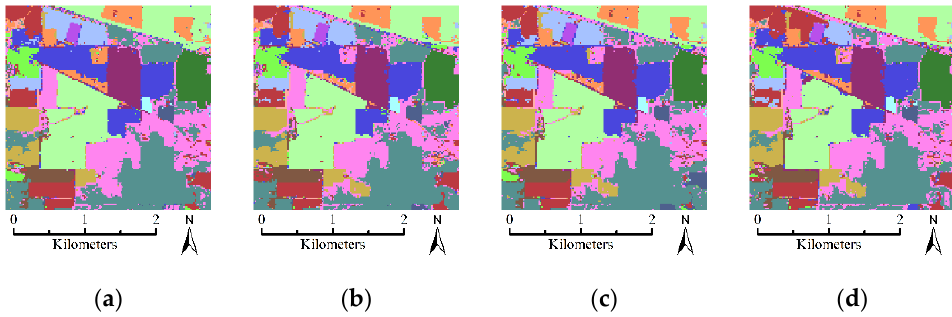
Figure 14. Classification maps obtained by using different strategies to ensure confidence for Indian Pines dataset: ( a ) with SC and ASR (90.90%); ( b ) with SC (90.61%); ( c ) with ASR (90.16%); and, ( d ) without SC or ASR (87.76%).